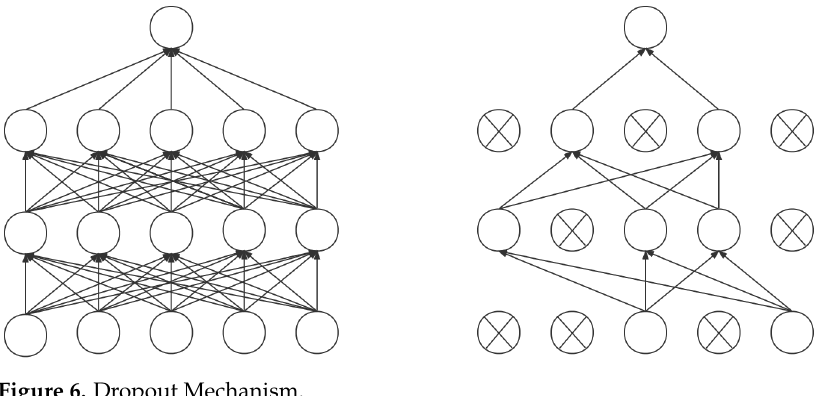
Figure 6. Dropout